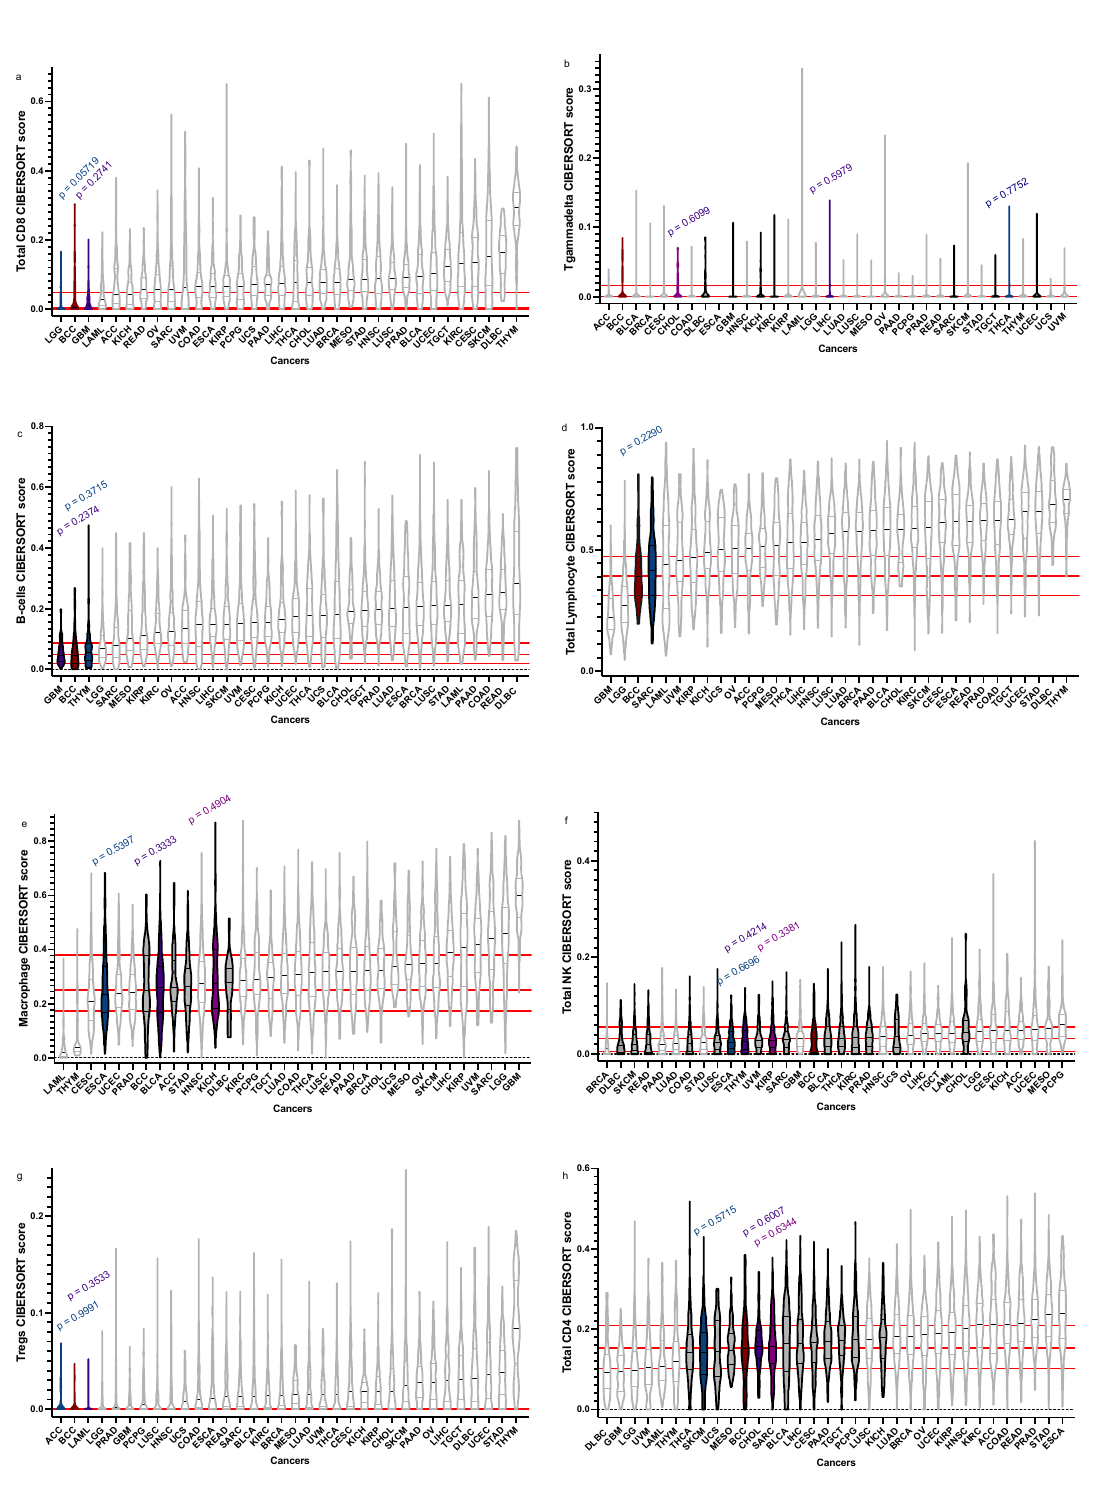
Figure 2. BCC vs. BCC “relatives”: CIBERSORTx. In silico immune cell fractions obtained using CIBERSORTx, comparing BCC (dark red) to other BCC “relatives” (white), with statistically similar cancers denoted (grey), with the top three in colour (dark blue, purple, violet) with their correspond- ing p -values above. Truncated violin plots of total CD8 T cells ( a ), T gamma delta cells ( b ), total B-cells ( c ), total lymphocytes ( d ), total macrophages ( e ), total NK cells ( f ), regulatory T cells (Treg) ( g ), and total CD4+ cells ( h ) are shown in order of ascending median. BCC median, 1st quartile, and 3rd quartile are delineated in red (where